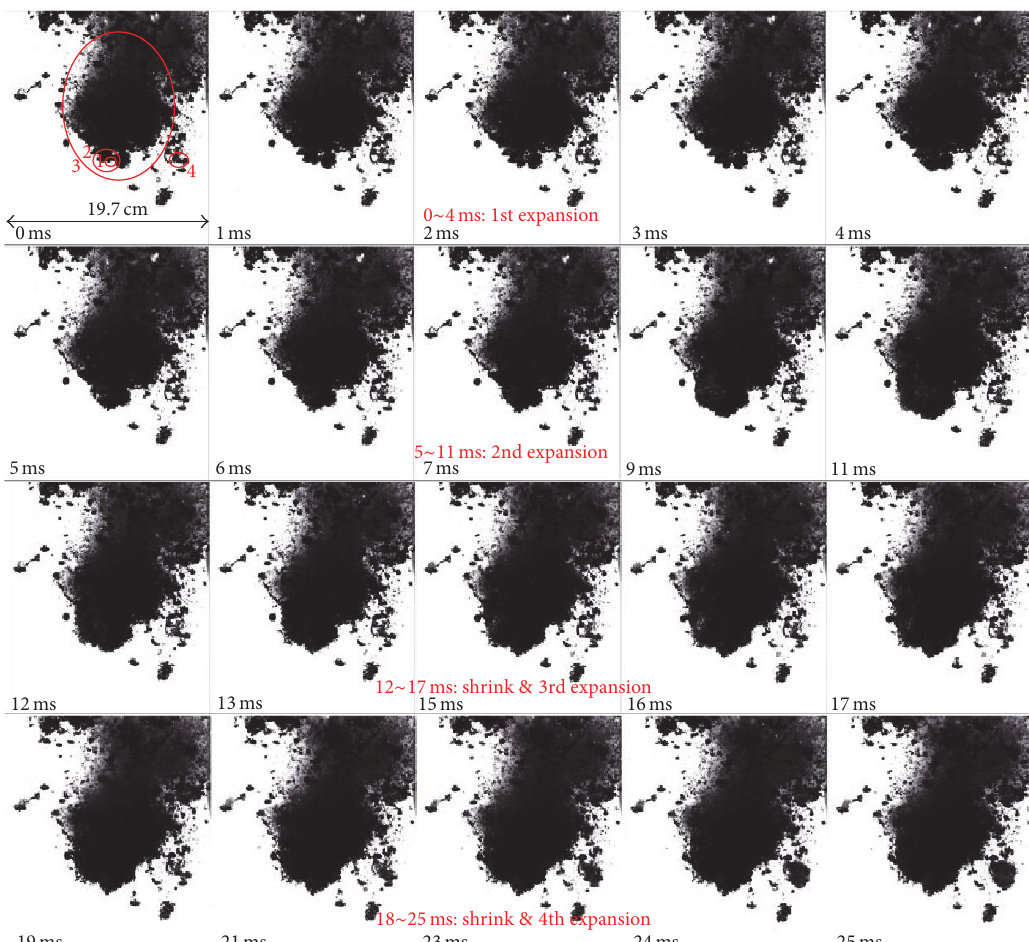
Figure 4: Local expansion phenomena in test